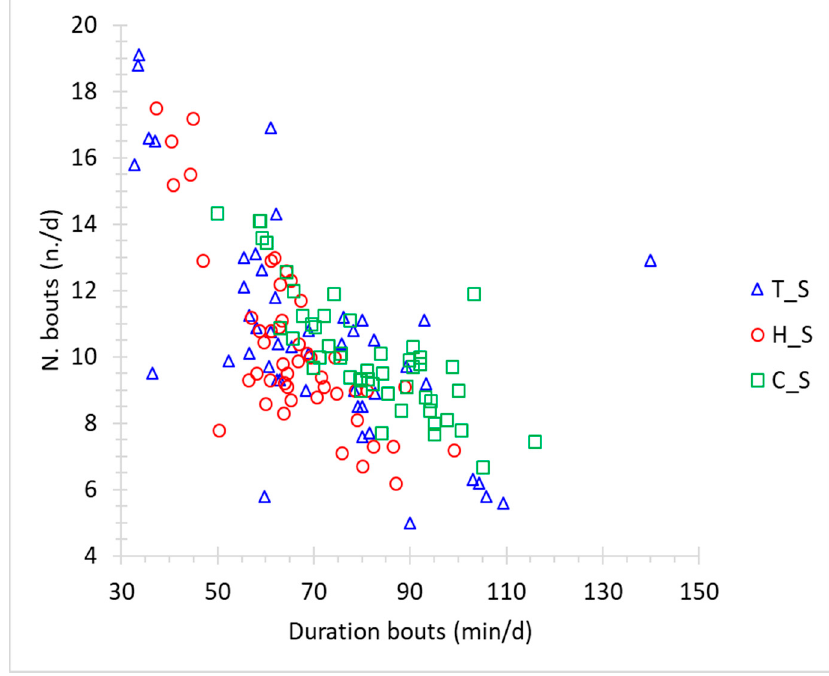
Figure 8. Relation between the daily number of lying bouts and their average duration in the three measurement periods (thermoneutral = T_S, hot = H_S and cold = C_S).